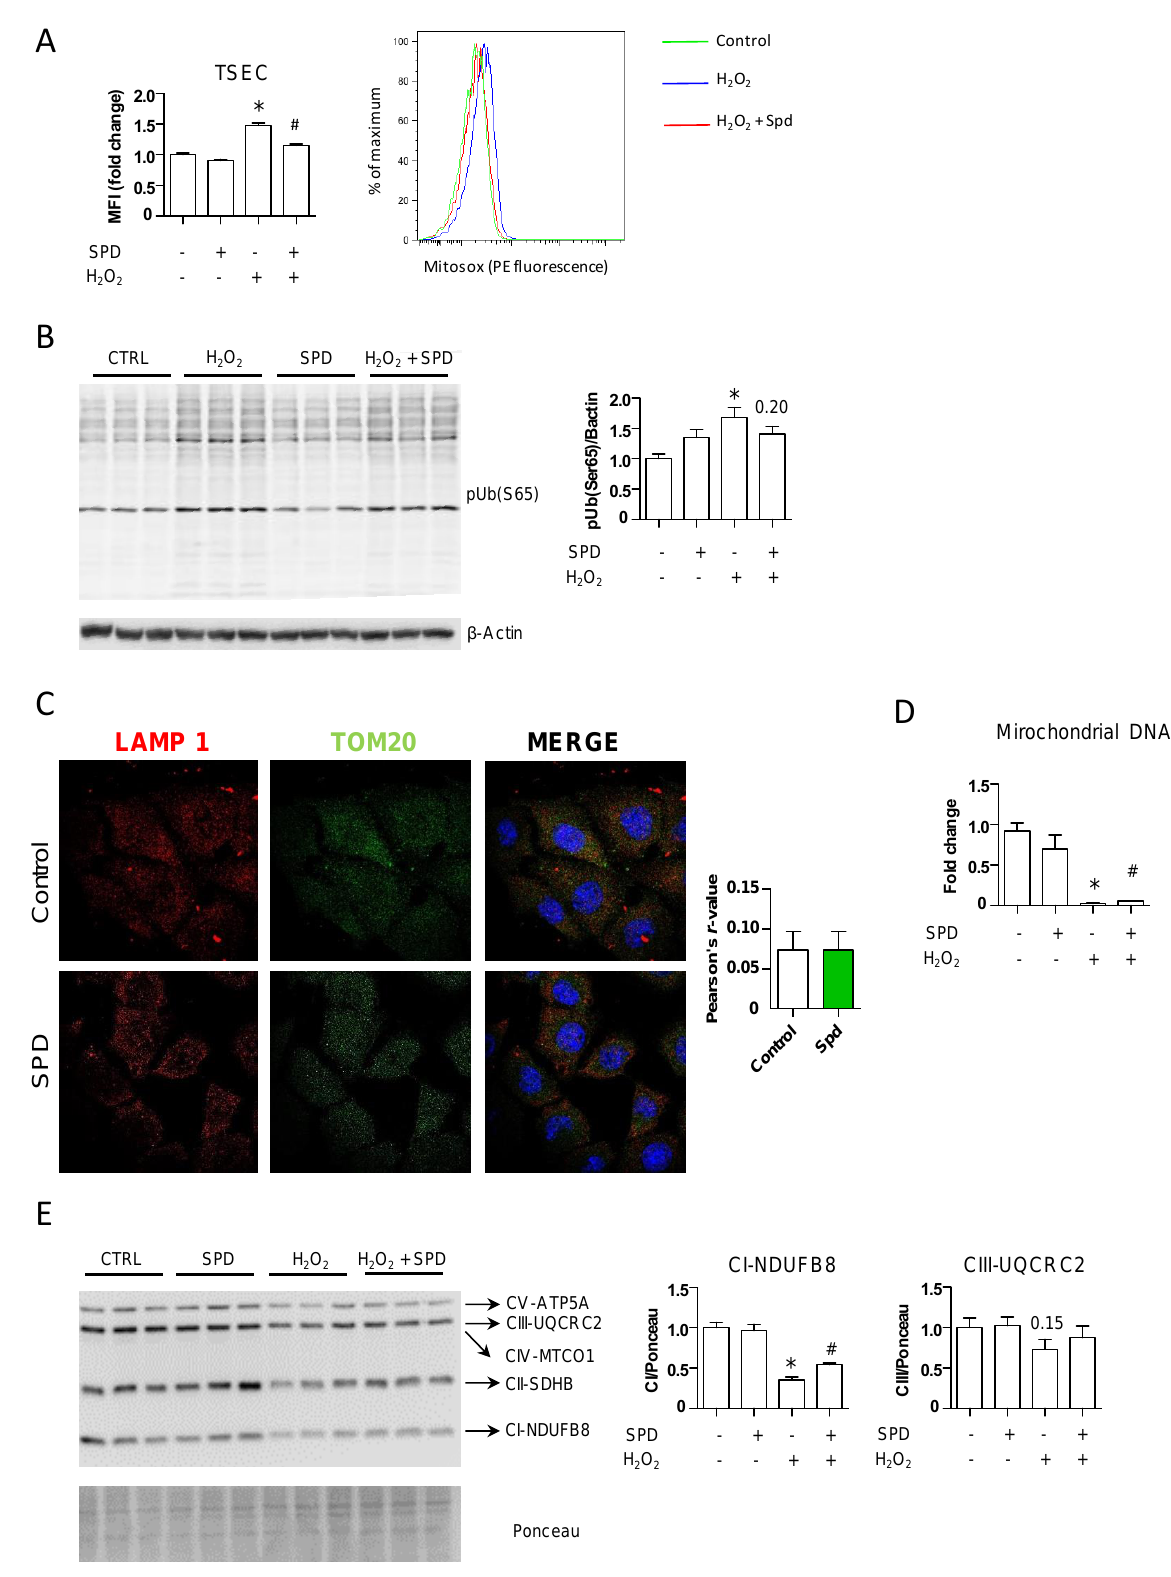
Figure 3. SPD protects mitochondria by reducing oxidative stress in vitro. ( A ) The TSEC were seeded in 6-well plates in triplicates. The next day, the cells were pretreated with SPD for 24 h. The medium was then changed, and H 2 O 2 was added for another 24 h. The cells were then incubated with MitoSOXTM (2.5 µ M for 10 min at 37 ◦ C) before being trypsinized, washed, resuspended in DPBS + DAPI and analyzed by means of flow cytometry. One representative of the two